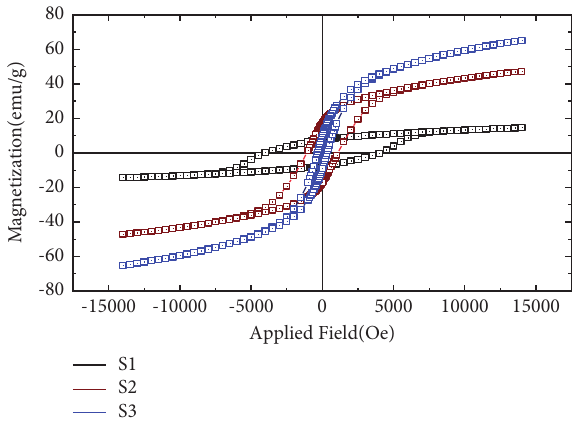
Figure 3: Hysteresis loop of samples (S1, S2 and